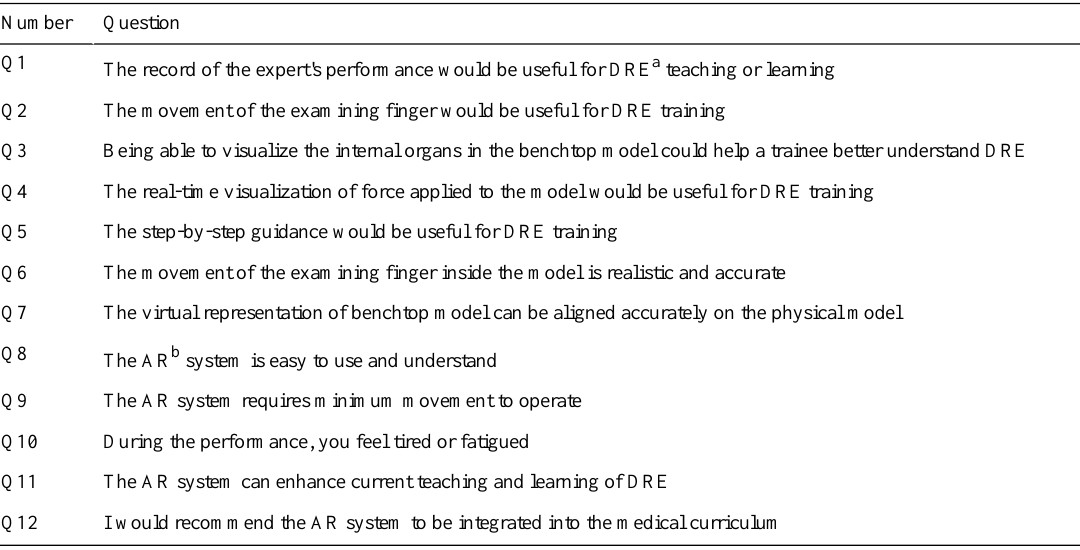
Table 1. Questions assessing the usefulness of the system.